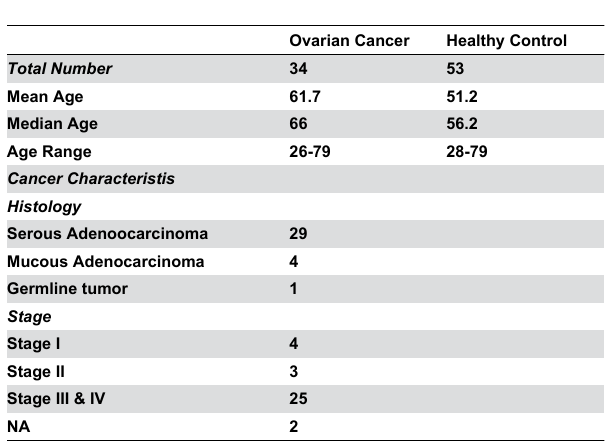
Table 1. Study population characteristics.